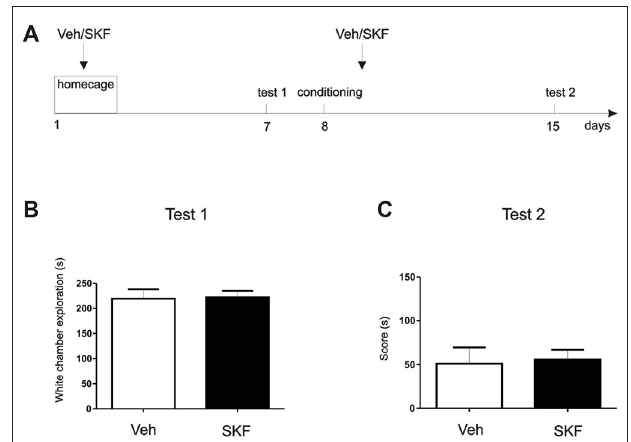
FIGURE 4 | D1/D5 activation on the mPFC did not generate the aversive behavior without white compartment conditioning. (A) Schema of the protocol used. (B) Previous any exposure to the apparatus, animals were infused with D1/5R agonist SKF 38393 in the mPFC and left on their homecage. Test/Pre—test was performed 7 days later. No differences were found in the exploration time of the white compartment ( p > 0.05, n = 10–11). (C) Animals were then conditioned only on the black compartment, and infused with D1/5R agonist SKF 38393 in the mPFC immediately after. A new test was performed 7 days later. No differences were found between groups ( p > 0.05, n = 10–11).